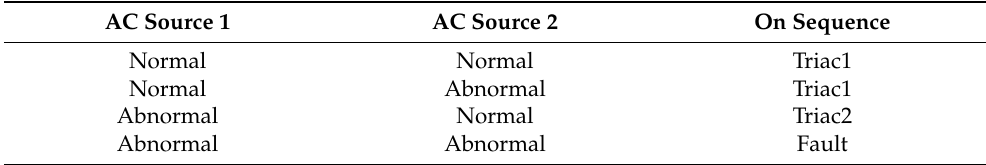
Table 2. The turn-on sequence of the Triac switches.